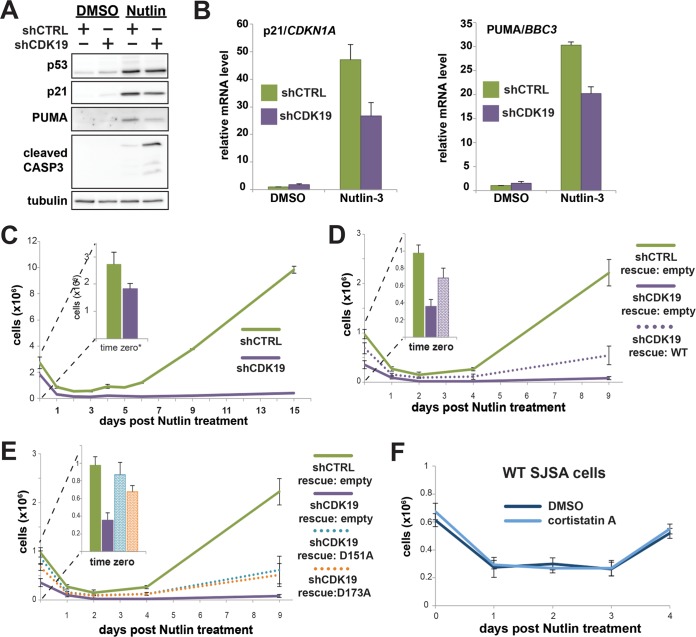
CDK19 knockdown sensitizes SJSA cells to nutlin-3. (A) Western blot data showing stabilization of p53 protein in nutlin-3-treated cells; p21, PUMA, and cleaved caspase-3 also induced in nutlin-treated shCTRL or shCDK19 cells. (B) qRT-PCR analyses confirm that nutlin-3 induces p53 target gene expression and reveal that, as suggested in 5-FU-treated cells, induction of select p53 targets is diminished in shCDK19 cells. (C) Cell proliferation following 24 h of nutlin-3 treatment (shCTRL or shCDK19). Whereas shCTRL cells recover to a proliferative state, shCDK19 cells do not (inset: cell counts immediately after nutlin-3 treatment). (D and E) Rescue expression of WT CDK19 (D) or kinase-dead versions of CDK19 (E) reestablish cell proliferation after nutlin-3 treatment, indicating that the physical presence of CDK19 is important for SJSA cells to return to a proliferative state following nutlin-3 treatment. (F) The Mediator kinase inhibitor CA, which inhibits both CDK8 and CDK19 (5), does not negatively affect SJSA cell recovery following nutlin-3 treatment, further implicating the CDK19 protein, not its kinase activity per se, as the underlying cause for the nutlin sensitivity.